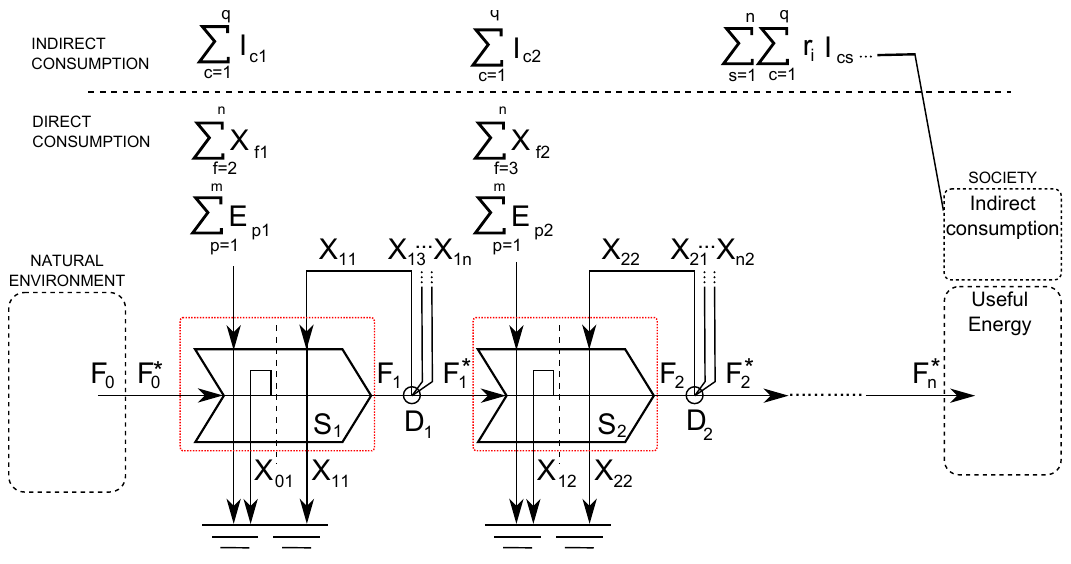
Figure 3. Energy production process with one pathway and n